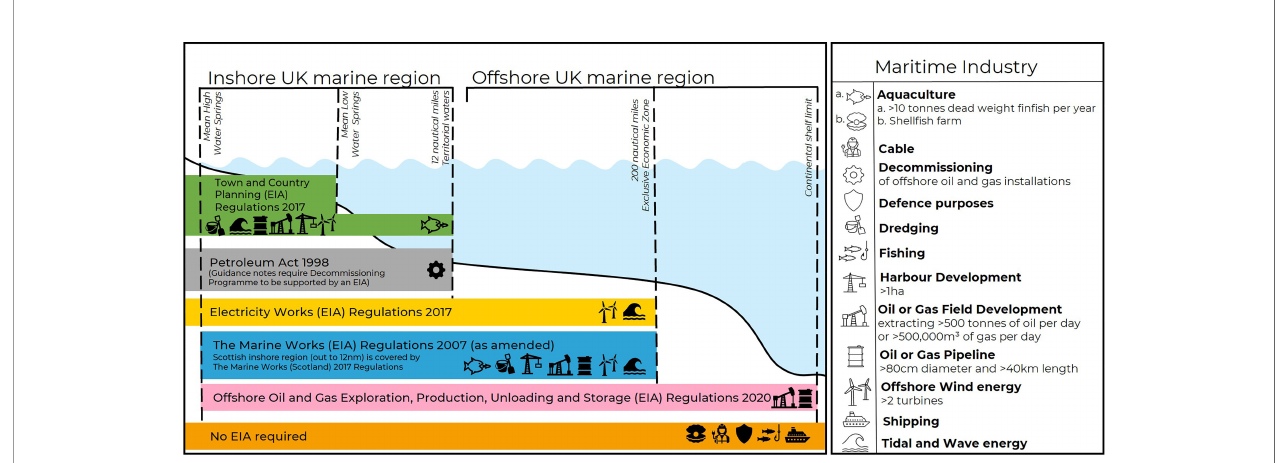
FIGURE 1 | Legislative regimes pertaining to the requirement for an EIA, and associated CEA, for various maritime industries within UK waters. Note, there are nuances in regulatory regimes and EIA requirements across devolved UK nations which are not captured within this fi gure. Thresholds for requirement of an EIA are also nuanced, and may vary subject to screening, for example if the proposed project is in a ‘ sensitive ’ area. This fi gure is presented for high level illustrative purposes only. Adapted from MMO Marine Licencing (2020) 7